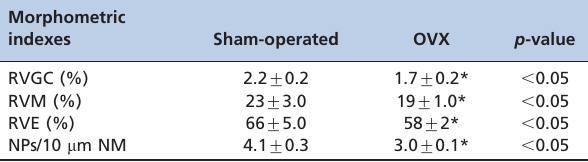
Table 2 - Morphometric indexes of the cardiomyocyte cytoplasm and nucleus in the RA of sham and OVX